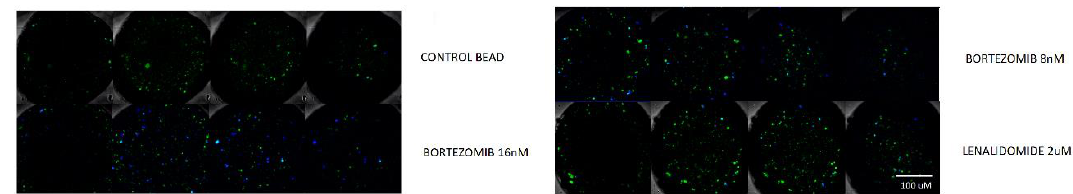
Figure 5. Confocal microscopy imaging of 4 di ff erent z planes for beads marked using FITC CD38 and DAPI. Z planes were chosen to image the maximum number of cells. From top to bottom: control bead, bead incubated with bortezomib 8 nM, bead incubated with lenalidomide 1 uM and bead incubated with lenalidomide 2 uM.